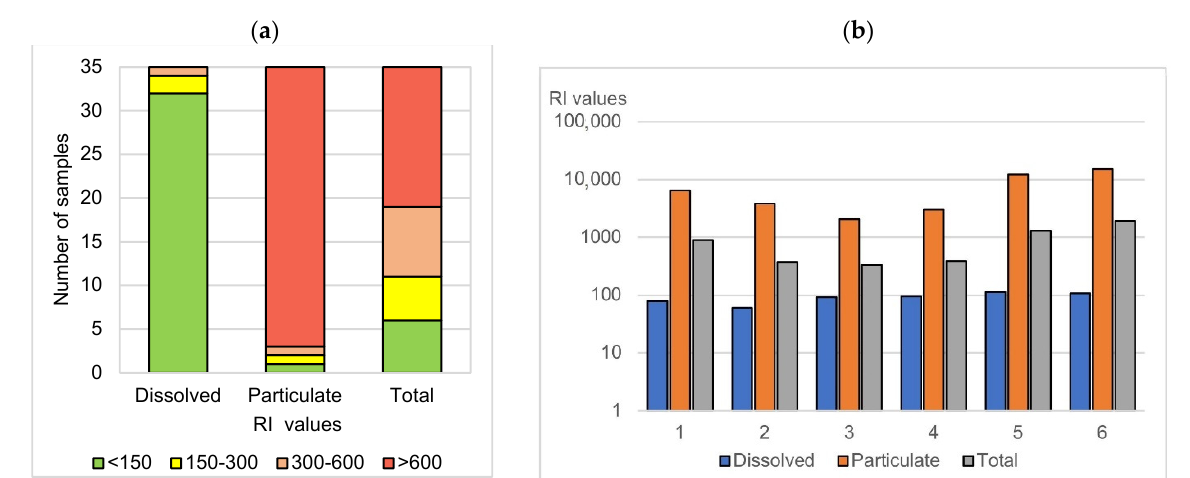
Figure 7. RI distribution in Tyumen City: ( a ) the frequency distribution of RI total values in snow samples and ( b ) mean values of RI within different land-use areas, based on the total content of particulate and dissolved TMMs in the snowpack. Land-use areas: 1—the historical center; 2—low-rise residential area; 3—high-rise residential area; 4—modern business zones; 5—industrial zones; 6—transport zones.